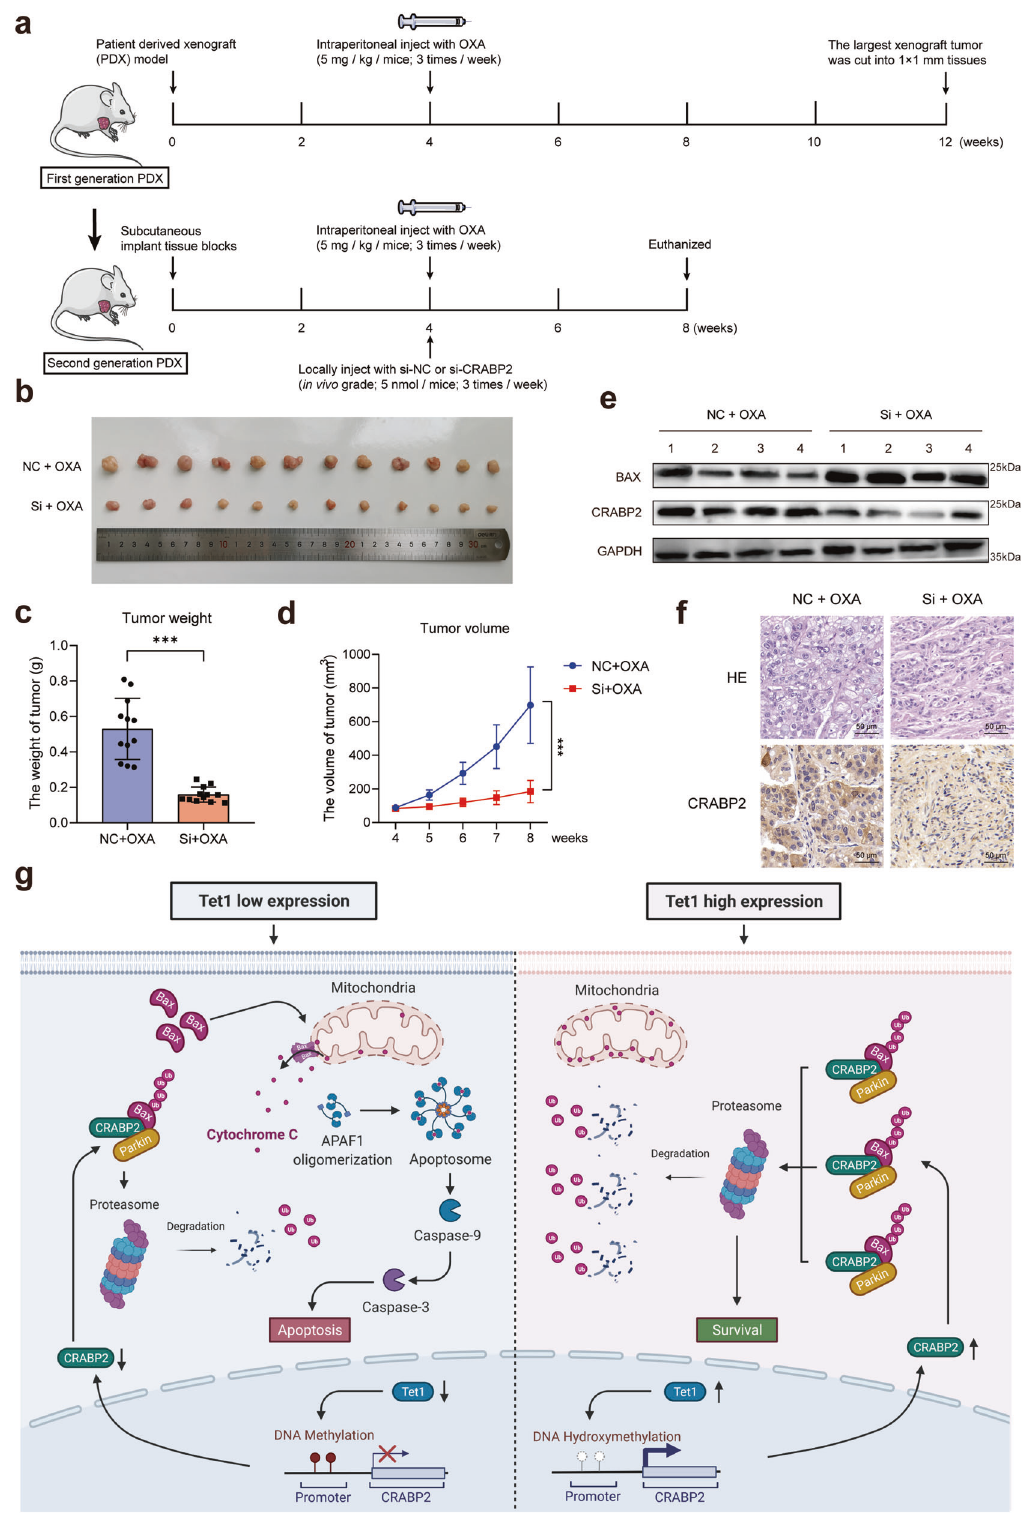
Fig. 7 Interference with CRABP2 reversed oxaliplatin resistance in GC in vivo. a Schematic diagram of the patient-derived xenograft model of GC. b Photos of different tumor formations in the two groups of NOD-SCID mice. Tumor weight ( c ) and tumor volume ( d ) measurement in the two groups of mice. e Expression of CRABP2 and BAX in tumors from the two groups of mice, as determined by western blotting. f HE staining and CRABP2 staining of tumor slides from the two groups of mice. g Under normal physiological conditions, the synthesis and degradation of Bax in the cytoplasm are in equilibrium. When cells are treated with oxaliplatin, Bax integrates into the outer mitochondrial membrane, leading to the release of cytochrome C and cell apoptosis. In chemoresistant GC cells, in which the expression of CRABP2 in the cell is at a high level, CRABP2 can promote the ubiquitination degradation of Bax by combining Bax and Parkin, ultimately allowing the cells to survive. * P < 0.05, ** P < 0.01, *** P < 0.001. Cell Death and Disease (2022)